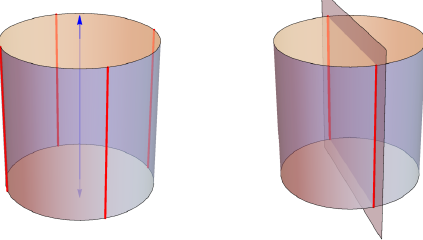
FIG. 5. Illustration for the hinge state protected by a fourfold screw (left diagram) and a glide (right diagram) on a cylinder geometry with periodic boundary conditions along the screw